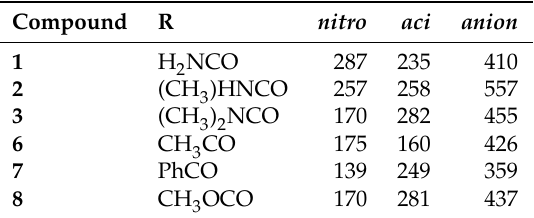
Figure 3. Time evolution of N-C α -C β -N γ dihedral angle ( Φ ) with R = H and (CH ) NCO (thick line) within BO–MD simulations performed with the density-functional 3 2 tight-binding (DFTB) model. Vertical lines separate the simulation of nitro (left), aci (middle) and ionized (nitronate) forms (right), respectively. Table 3. Hydrogen bond population (%) for all H-bond donor and acceptor groups in the investigated compounds (residue R, see Table